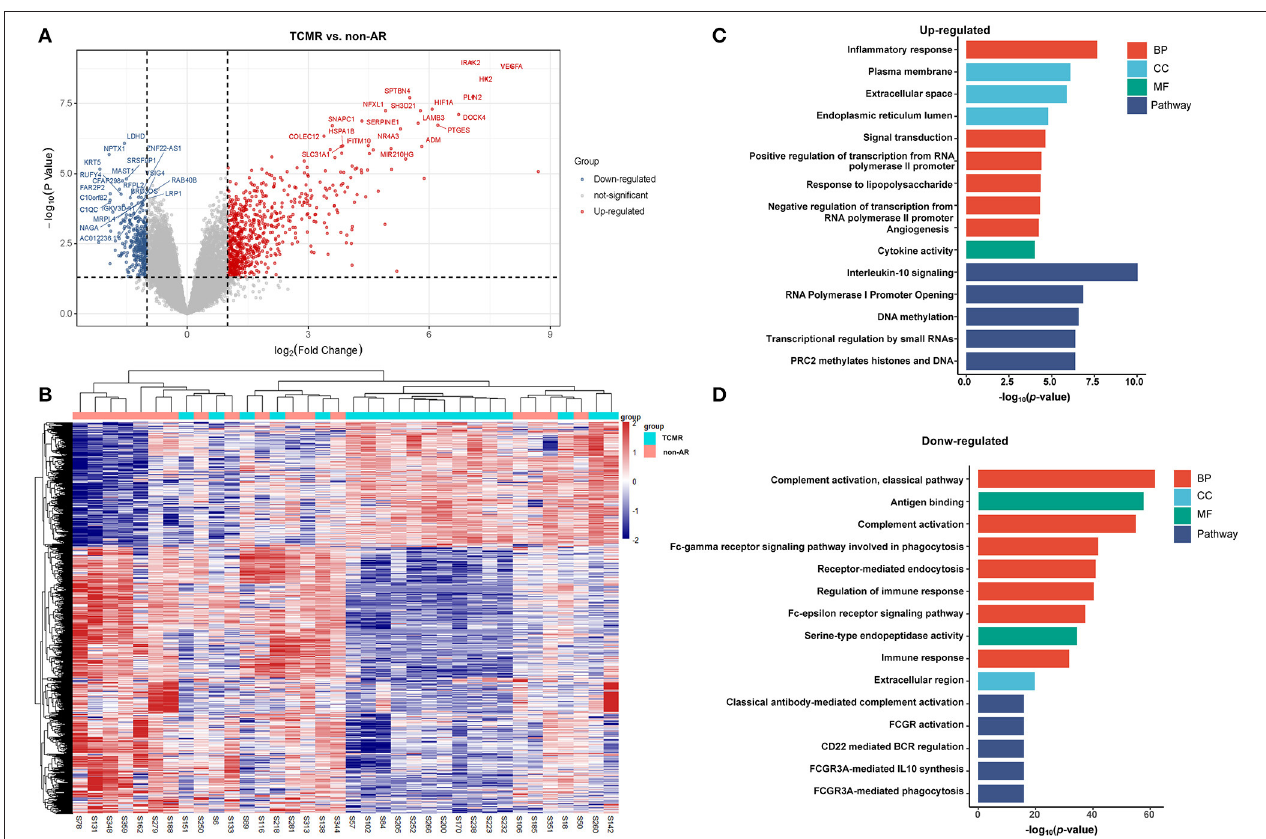
FIGURE 3 | DEGs and GO analysis in (TCMR and non-AR recipients). (A) Volcano map of DEGs in TCMR vs. non-AR recipients. Red represents upregulated genes, and blue represents downregulated genes. A total of 1,375 genes were identified as DEGs in PBMCs of patients with TCMR, among which 936 were upregulated and 439 were downregulated. (B) Hierarchical clustering heatmap analysis of DEGs. Red represents upregulated genes, and blue represents downregulated genes. (C) GO and pathway analysis of upregulated DEGs. GOs of inflammatory response and IL-10 signalling were the most significant enrichments. (D) GO and pathway analysis of downregulated DEGs. GOs of the complement activation and the classical antibody-mediated complement activation pathway were the most significant